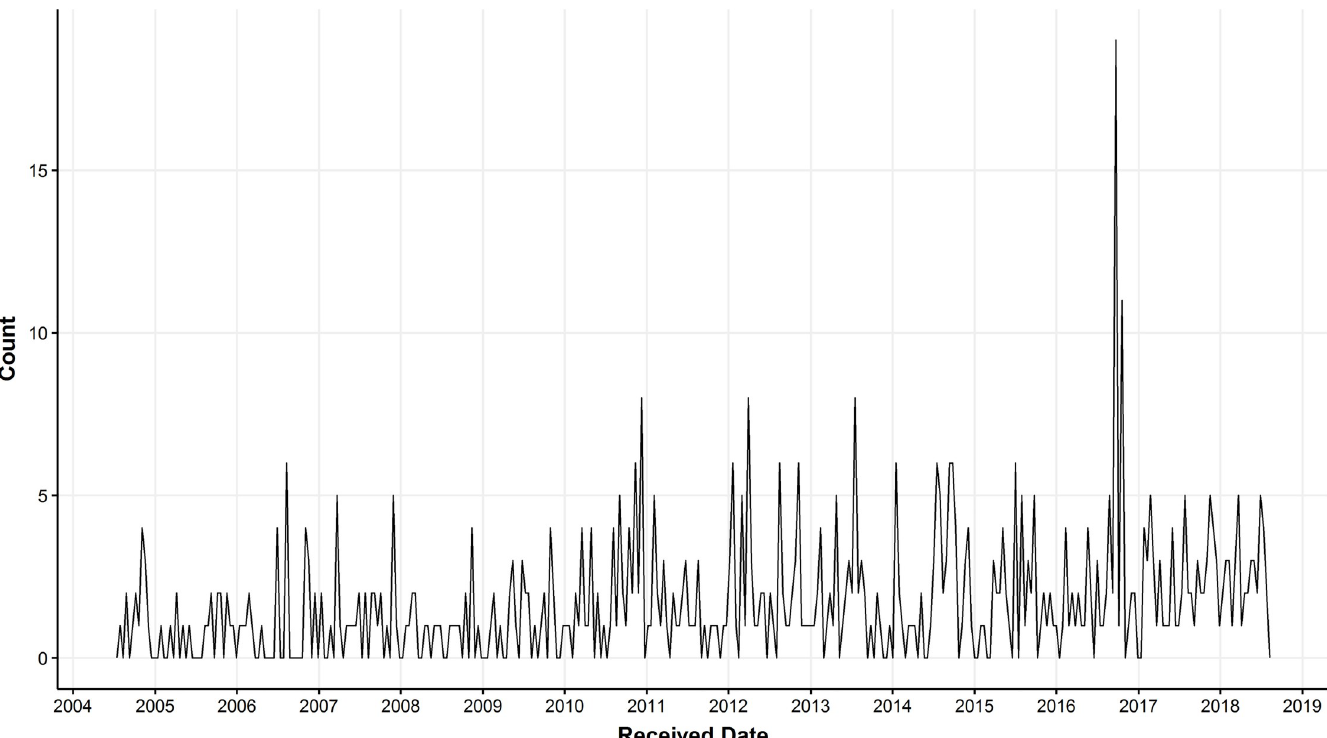
Fig 10. Time series of GI cases. Number of GI cases in small animal exotic species, based on syndromic predictions. There is a noteworthy increase in the number of GI cases in the fall of 2016. Counts are based on grouping cases into 14-day bins.